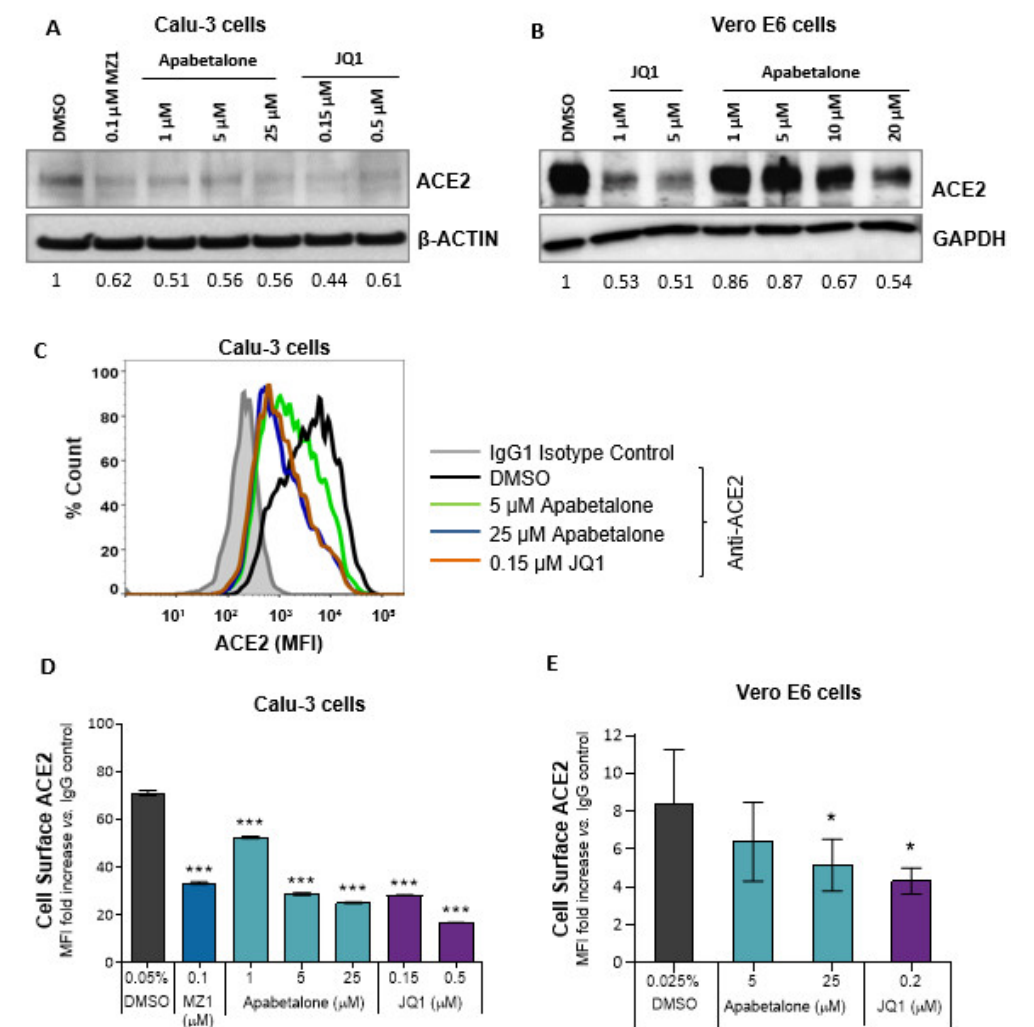
Figure 2. BETi treatment reduced both surface and total ACE2 protein levels. ( A ) Immunoblot of total ACE2 protein in Calu-3 cells following BETi treatment for 48 h. Values below the blots indicate band quantification via densitometric analysis (ACE2 / β-ACTIN) and are represented as fold change to vehicle-treated cells (0.05% v/v DMSO). ( B ) Immunoblot of total ACE2 protein in Vero E6 cells following BETi treatment for 48 h. Values below the blot indicate band quantification via densitometric analysis (ACE2/GAPDH) and are represented as fold change to vehicle-treated cells (0.1% v/v DMSO). ( C ) Representative histogram from flow cytometry showing overlay of cell surface ACE2 on Calu-3 cells following 48 h of the indicated treatments. ( D – E ) Quantification of ACE2 protein levels on Calu-3 (D; n = 3) or Vero E6 (E, n = 5) following BETi treatment for 48 h. ACE2 surface expression is shown as mean fluorescent intensity (MFI) ratio to isotype control ( D – E ). Error bars represent SD. * p < 0.05, ** p < 0.01, *** p < 0.001, one-way ANOVA followed by Dunnett's multiple comparison test.